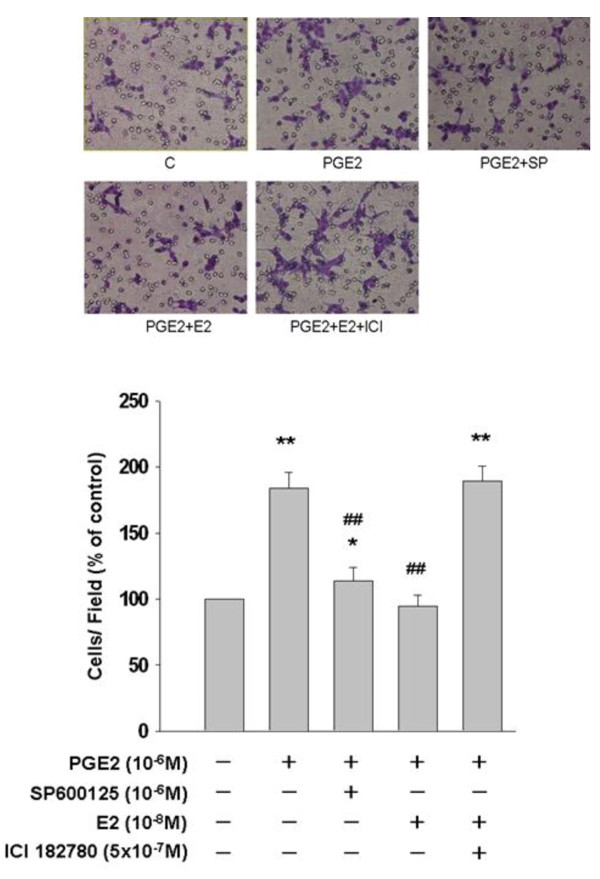
17β-estradiol inhibits PGE2-promoted cellular motility in human LoVo cells. LoVo cells were pretreated with vehicle, SP600125 (JNK1/2 inhibitor, 1 μM) or 17β-estradiol (10-8M) for 1 h prior to PGE2 (10-6M) treatment for another 48 h in hydroxyurea-containing DMEM, and subsequently observed the ability of migration in LoVo cells by migration assay. At the same time, LoVo cells were treated 17β-estradiol (10-8M) in the presence or absence of ERs inhibitor, ICI 182780 (5 × 10-7M). The responses to different treatments were observed and analysis with a light microscope. *, p < 0.05 versus control;**, p < 0.01 versus control. ##, p < 0.01 versus PGE2 treatment group (mean ± SE, n = 4).